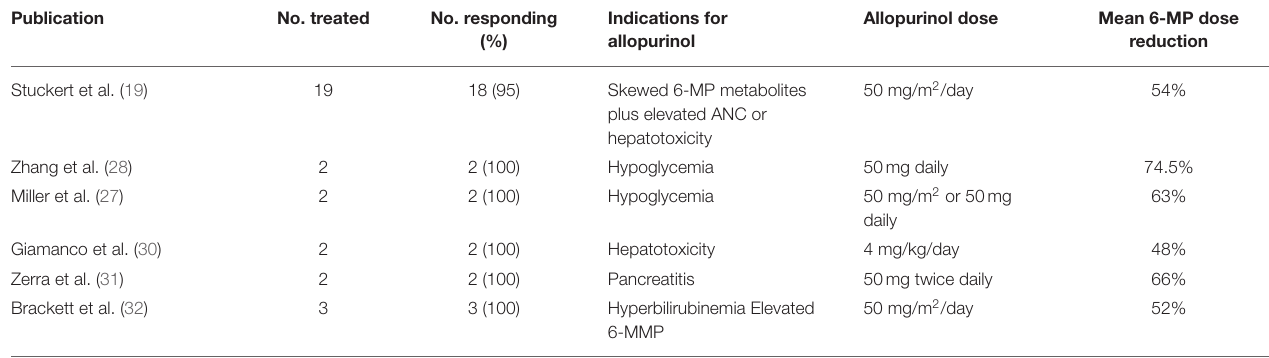
TABLE 1 | Summary of literature on combined allopurinol and 6-mercaptopurine therapy in